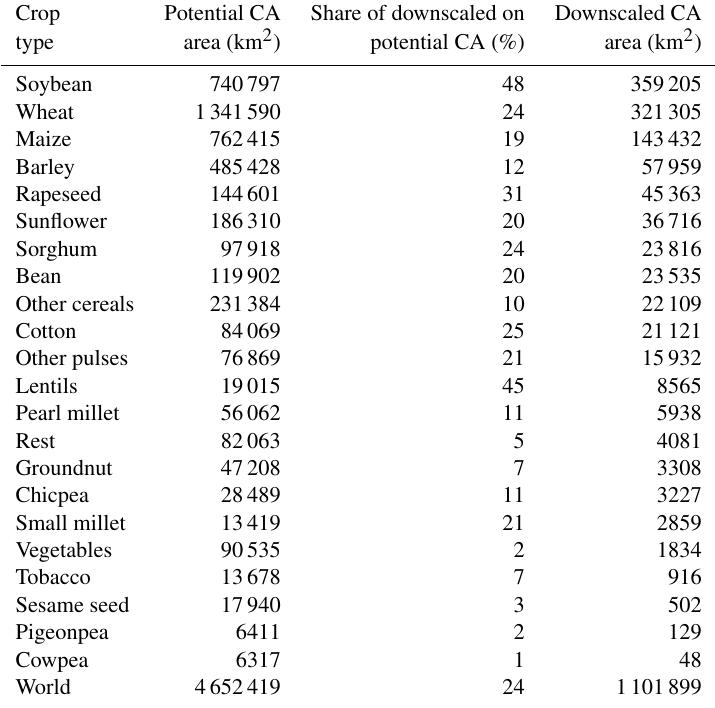
Table 6. Global sums over 22 CA suitable crop-type areas, sorted decreasing shares of downscaled CA area values on the identified potential CA area, and crop-specific downscaled CA